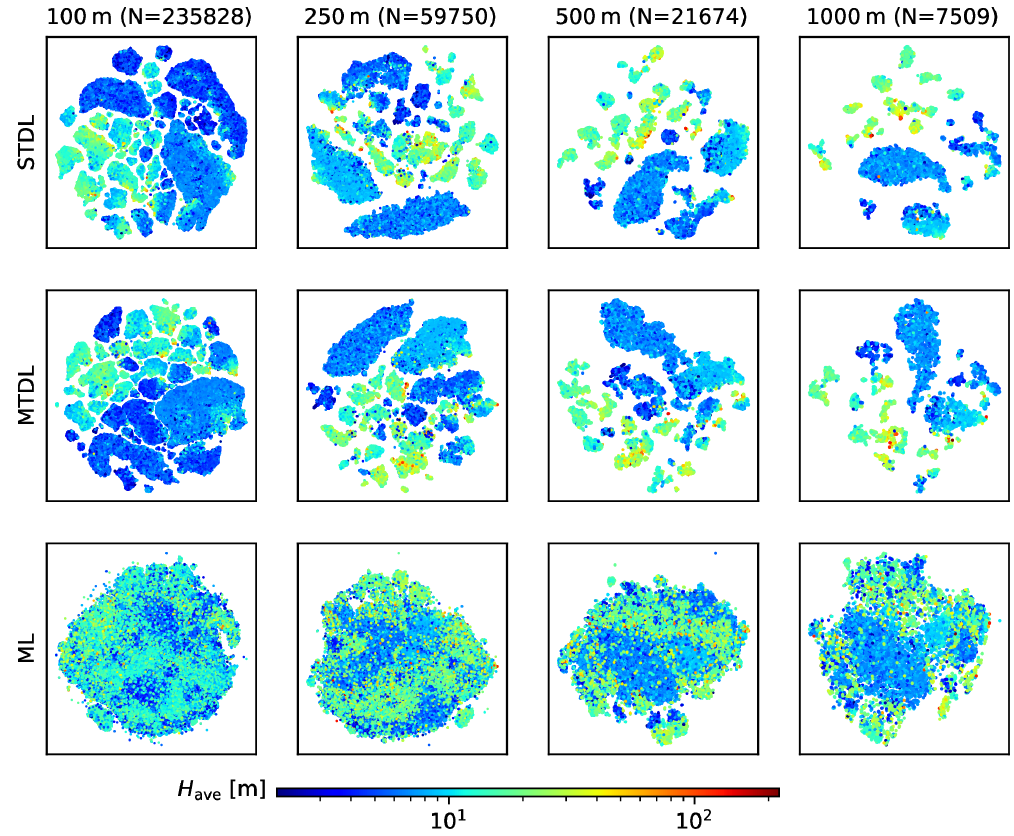
Figure 12. Visualization of features for building height prediction in D test , 2 using t -SNE. Features of STDL and MTDL models are defined as the output from the backbone part while features of ML models are extracted using techniques mentioned by Sect. A1. Table 3. Summation of the number of parameters for simultaneous building height and footprint prediction using STDL and MTDL models under different target